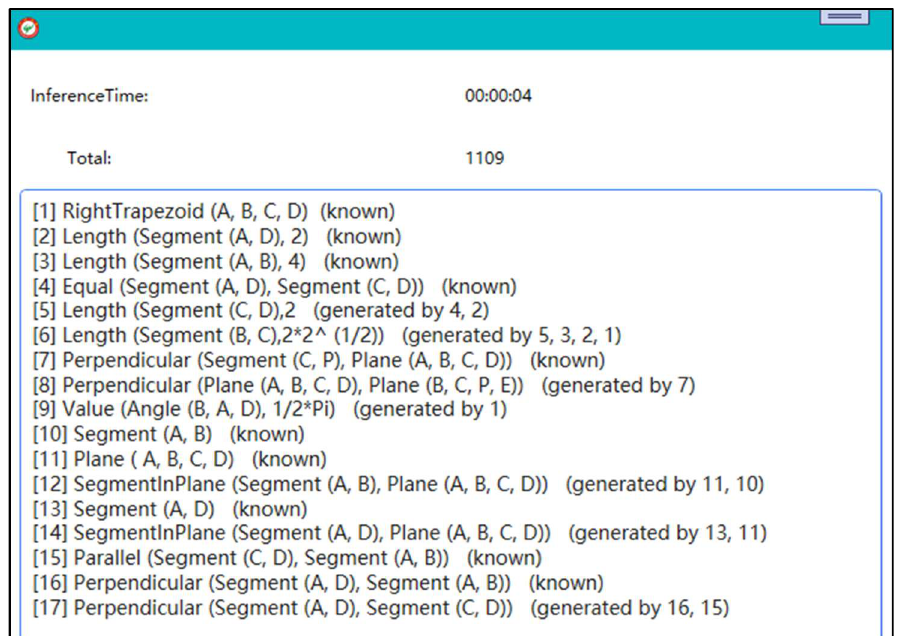
Figure 9. Results of first reasoning.